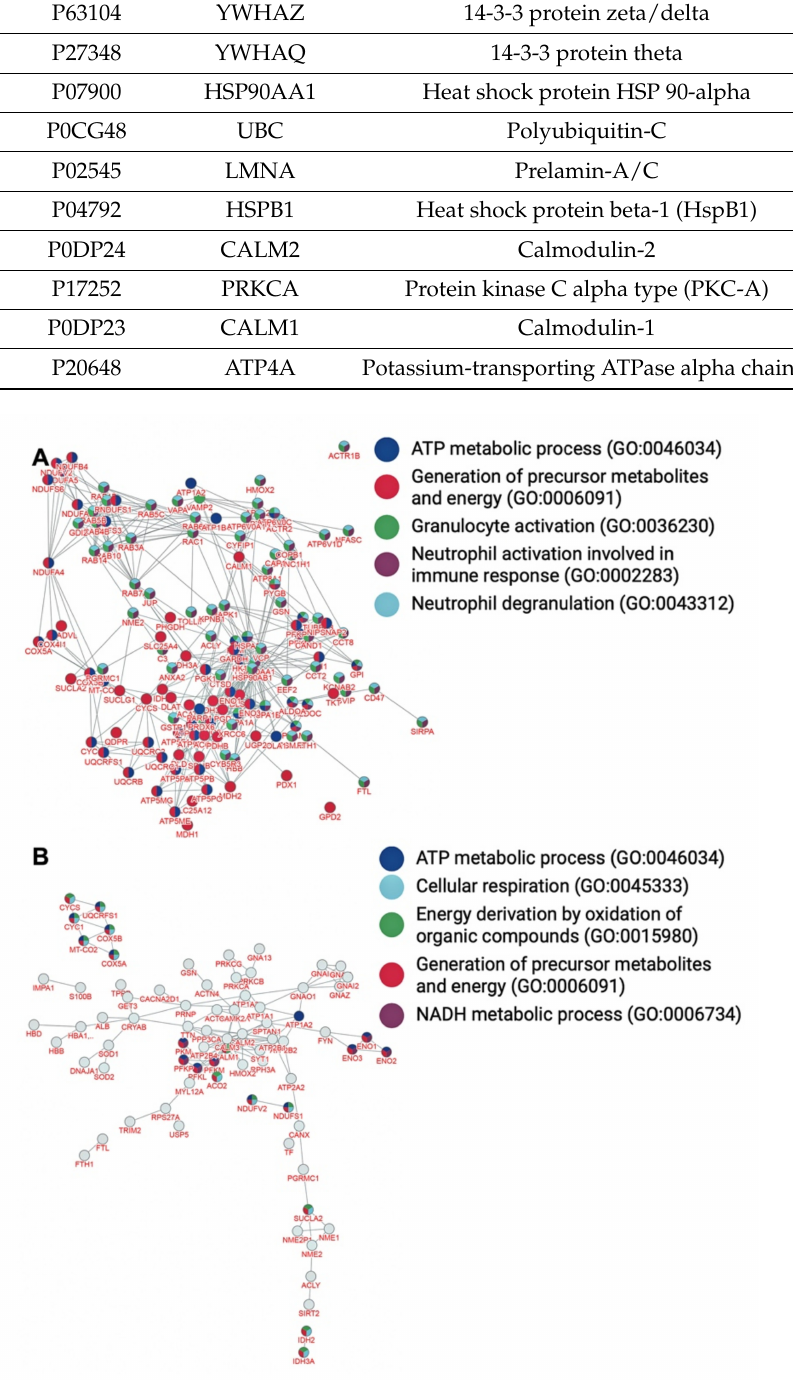
Figure 2. Functionally enriched PPI network of myelin ( A ) and sub-PPI network of metalloproteome ( B ) based on gene ontology (GO) terms of the